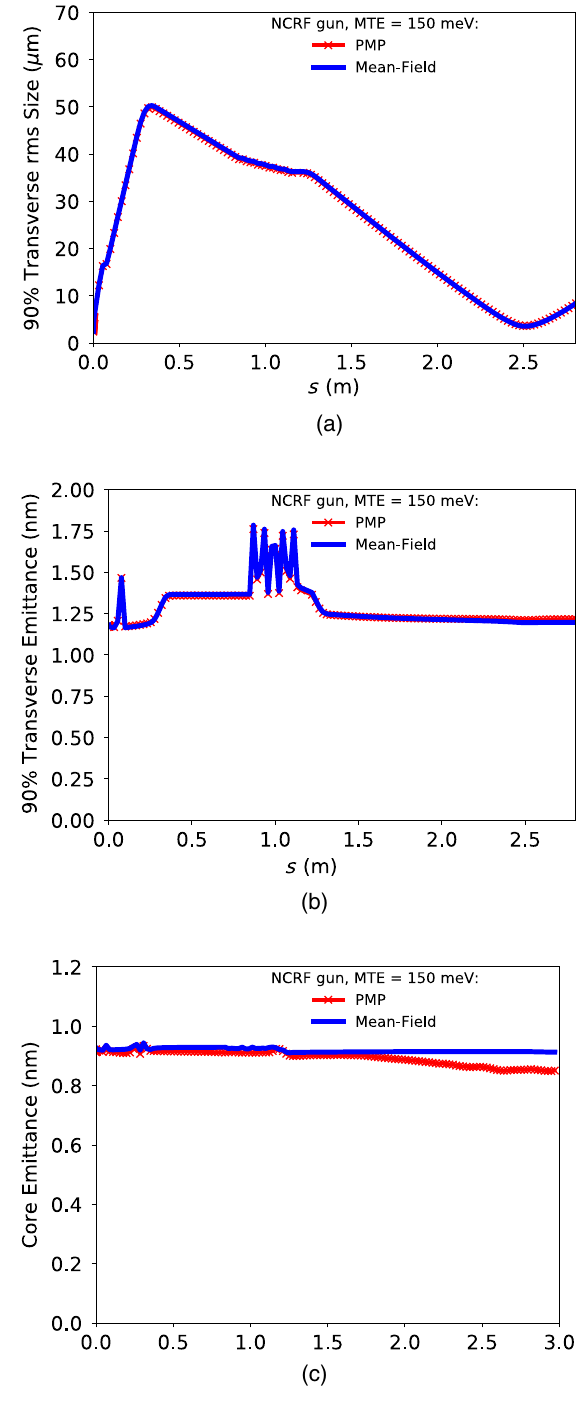
FIG. 15. (a) Spot size, (b) transverse normalized rms emittance, and (c) core emittance comparison between the PMP method and mean-field space charge simulations of the NCRF UED beamline with 150 meV